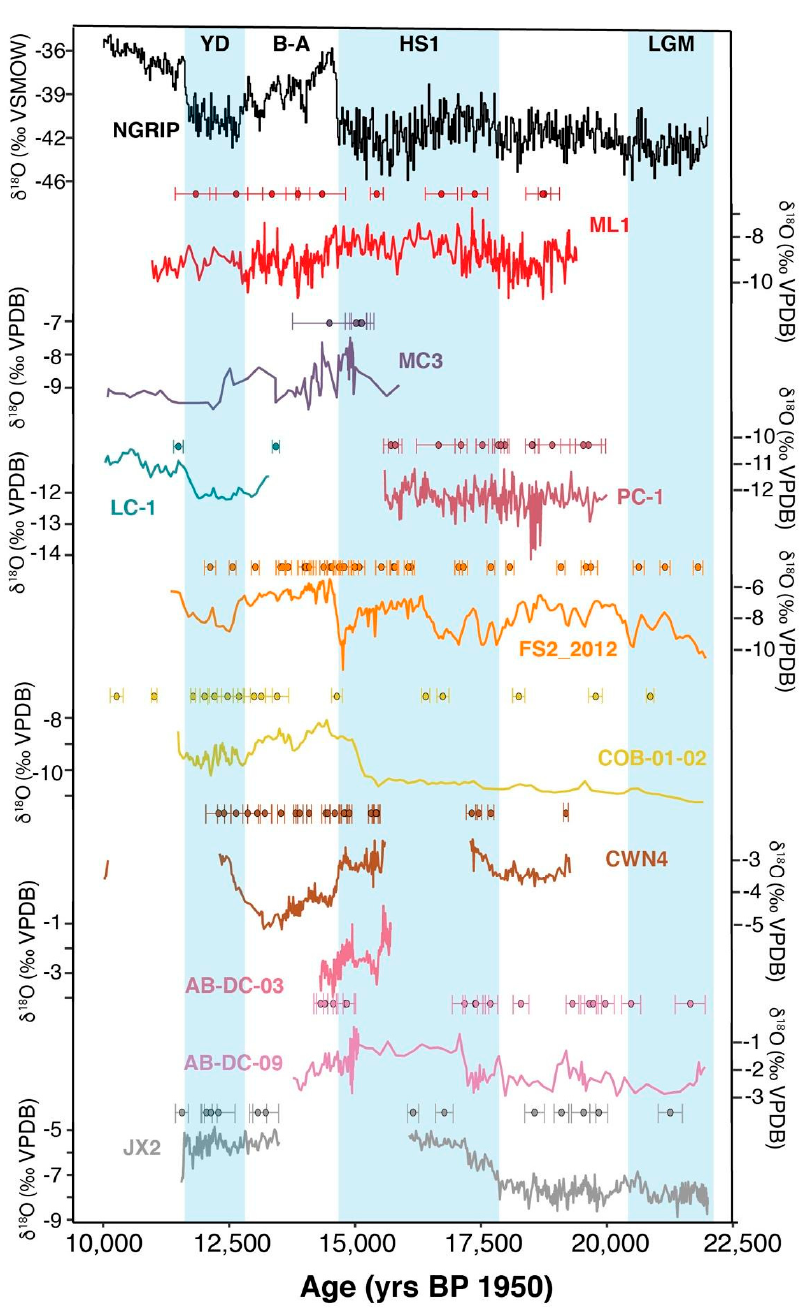
Figure 6. Speleothem records covering the LGM through the most recent deglaciation that are included in SISAL_v1 compared to the NGRIP δ 18 O record from Greenland [115]. See Table 1 for record details. Ages (solid circles) and associated uncertainties are shown with each record. Periods of Northern Hemisphere cooling are highlighted in blue. Records are arranged by